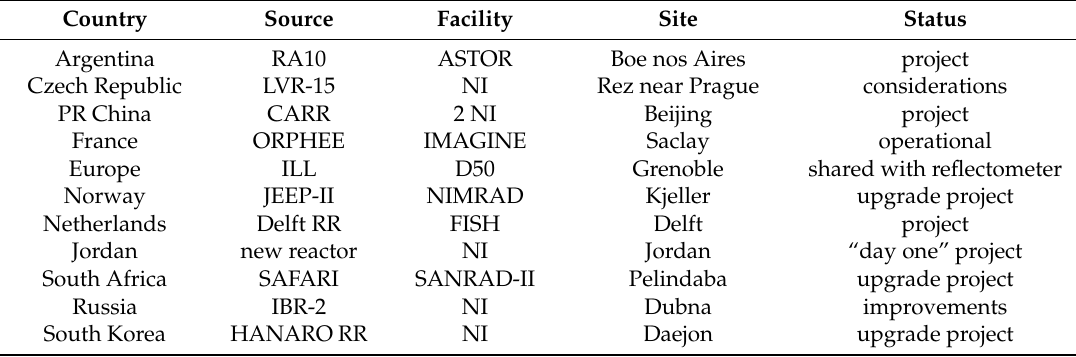
Table 5. Projects of new or upgraded NI facilities at reactors; for spallation sources see Table